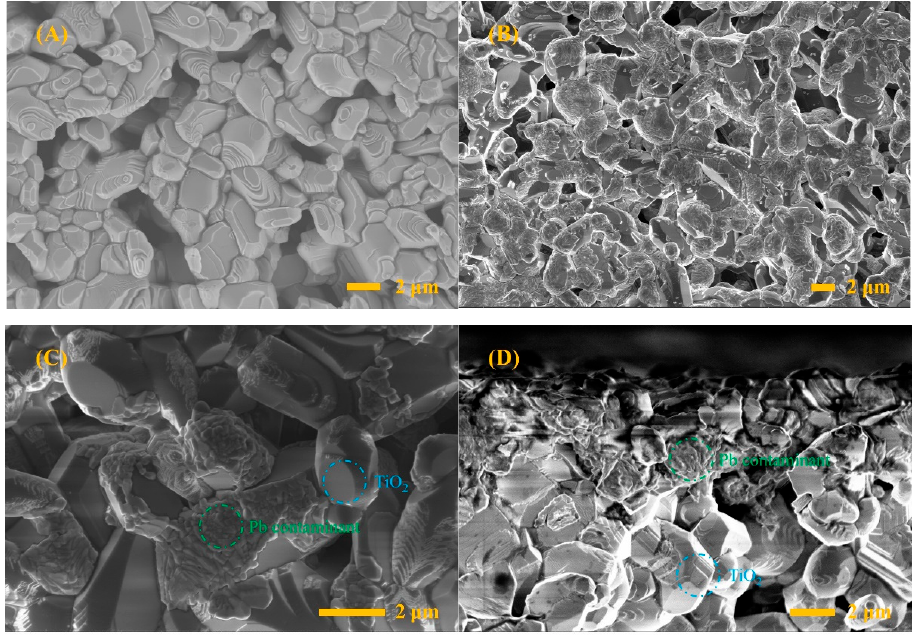
Figure 3. SEM images showing the surface morphology of TiO 2 ( A ), Pb ‐ TiO 2 ( B , C ) and the cross ‐ sectional morphology of Pb ‐ TiO 2 ( D ). sectional morphology of Pb-TiO 2 ( D